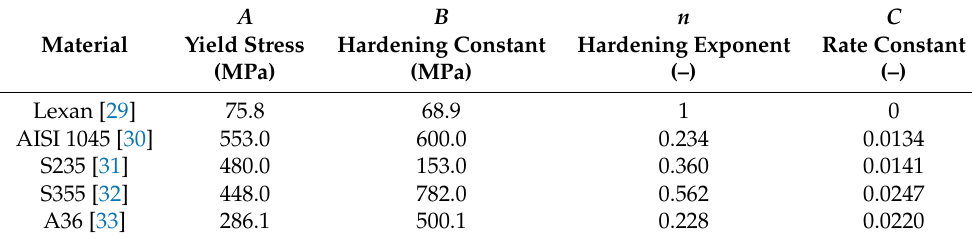
Table 3. Johnson–Cook constants for the studied